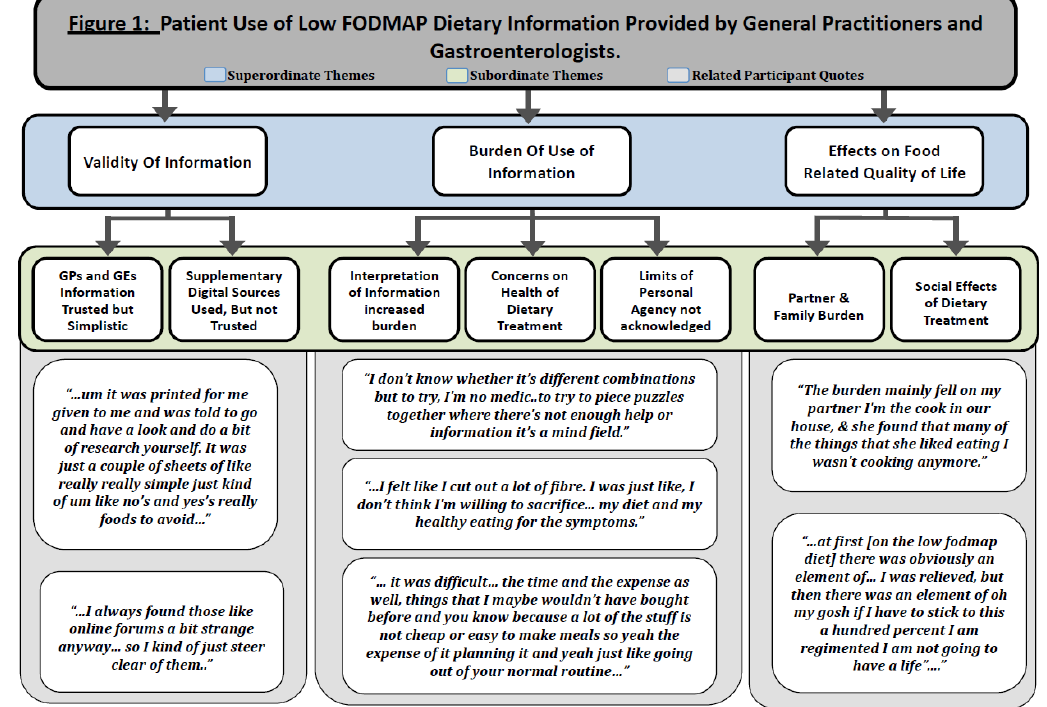
Figure 1. Patient use of low fermentable oligosaccharides, disaccharides, monosaccharides and polyols (low FODMAP) dietary information provided by general practitioners and gastroenterologists.